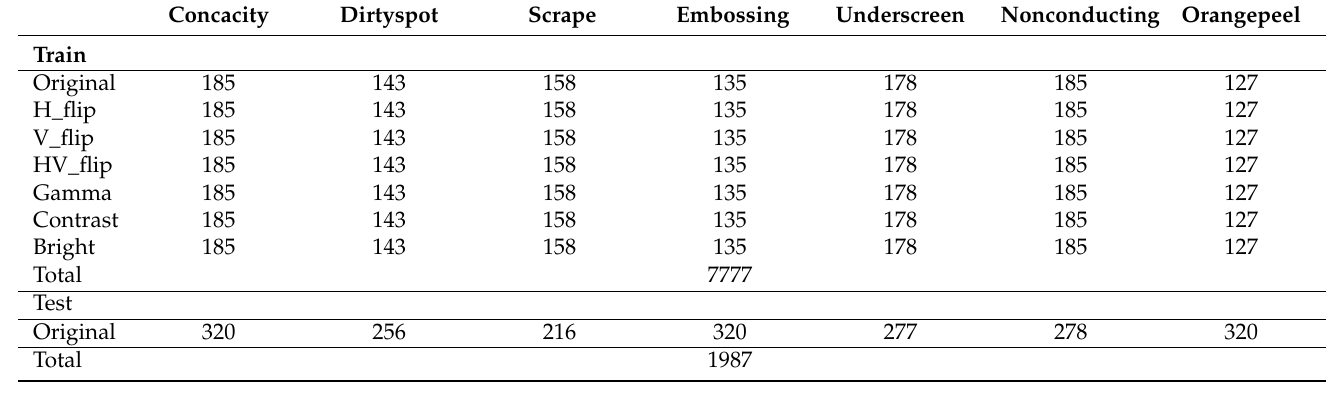
Table 1. Dataset consisting of various classes of defects.